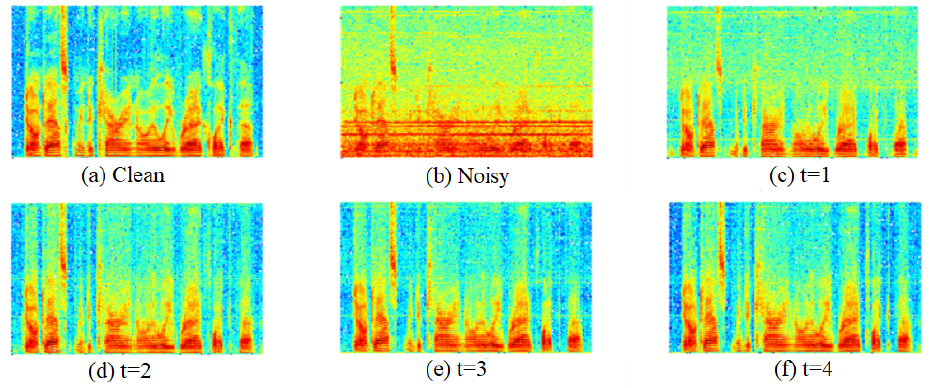
Figure 6. Spectrogram of synthesized speech enhanced by the RRSENet model.